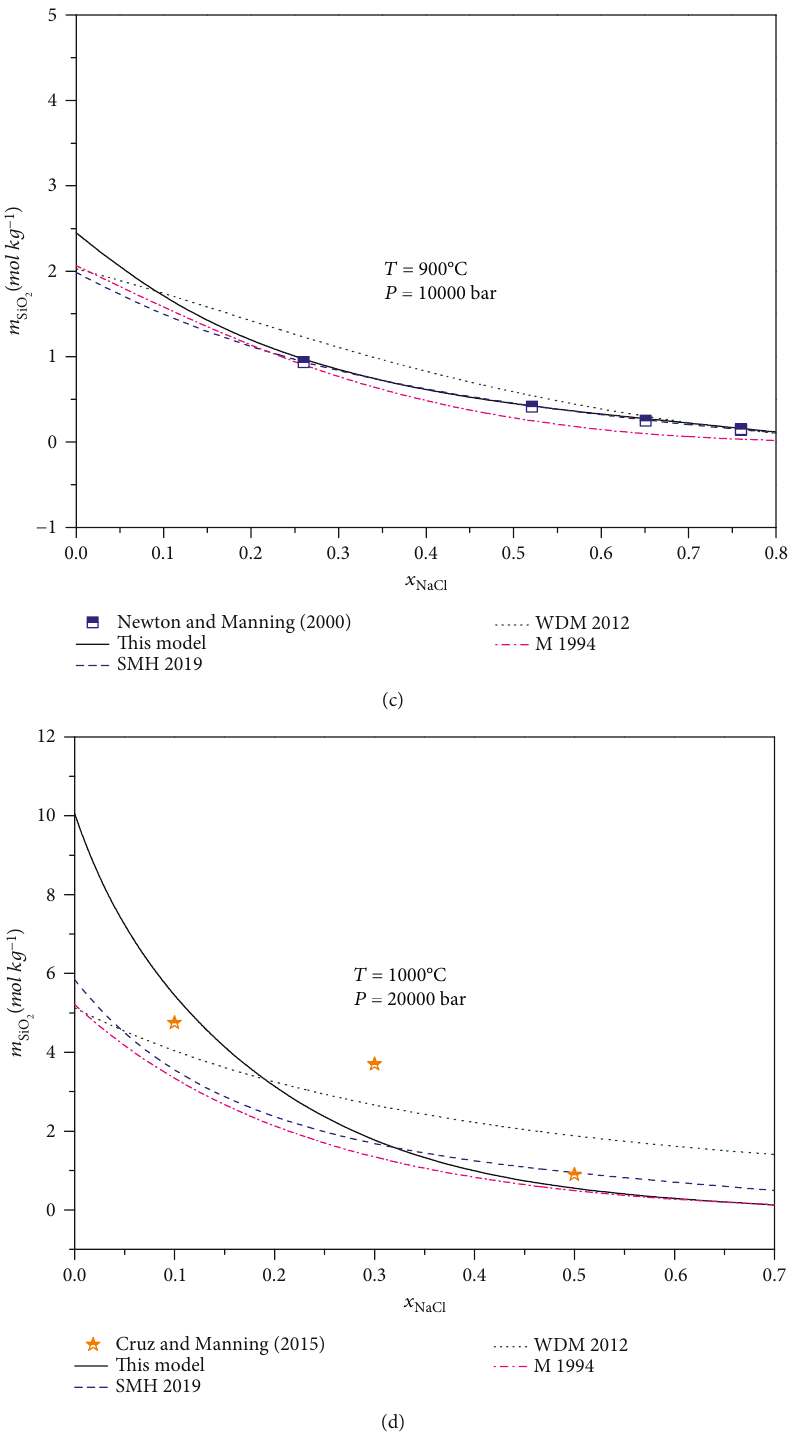
Figure 6: Comparisons of model extrapolation to high temperature and pressure hydrothermal conditions. (a, b) Computing results of di ff erent models in pure water. (c, d) Computing results of di ff erent models in H curves, and dash dot curves present the predictions of this model, the SMH 2019 model, the WDM 2012 model, and the AD 2009 model,